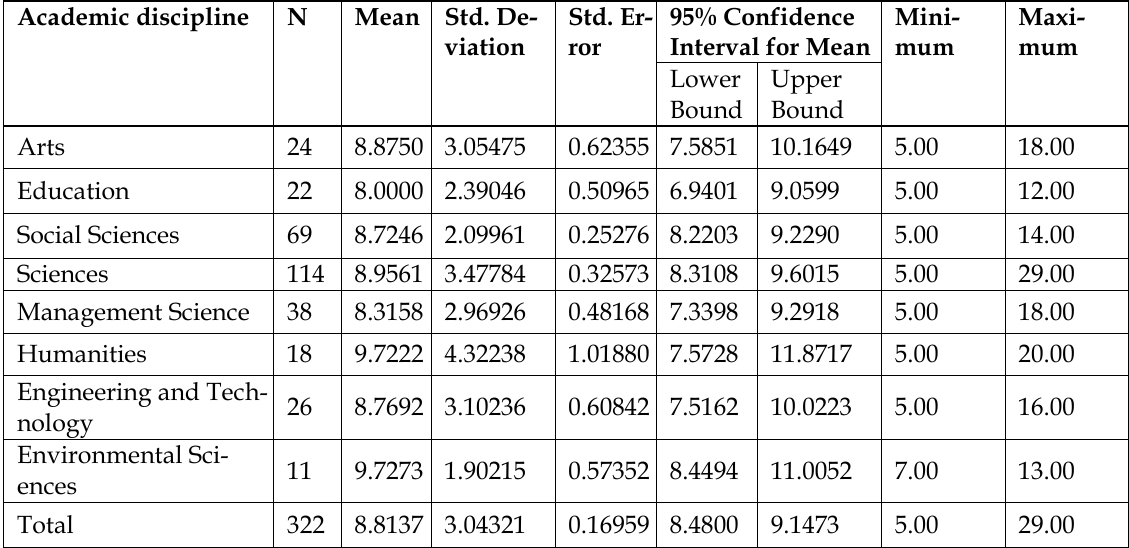
Table 9b: One-way ANOVA test for academic discipline